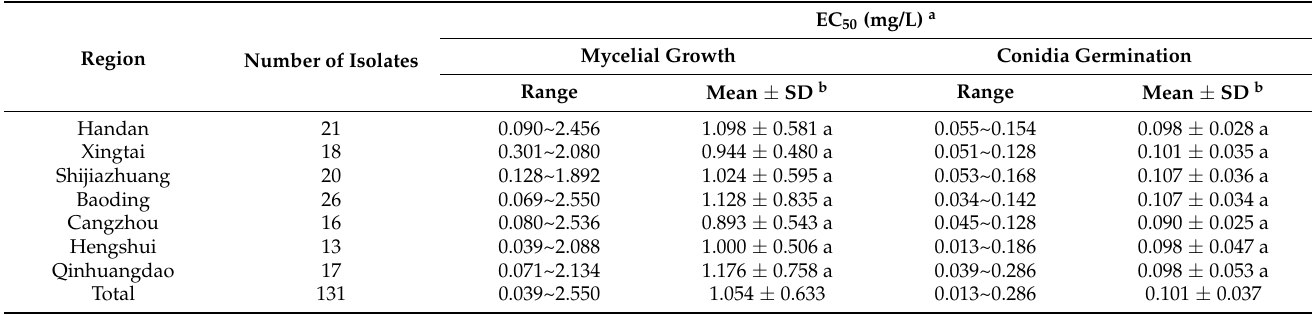
Table 2. Sensitivity baseline to penthiopyrad of 131 Botrytis cinerea isolates sampled from tomato plants affected by gray mold cropped in Hebei Province (China) during 2015–2017 without SDHI fungicide application.